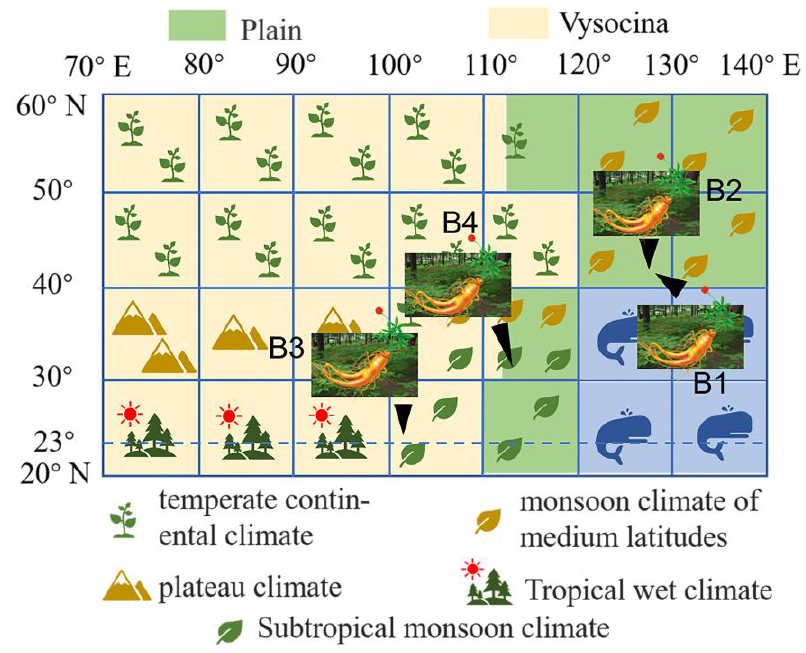
Figure 6. Geographic distribution of 4 groups of P. ginseng samples.